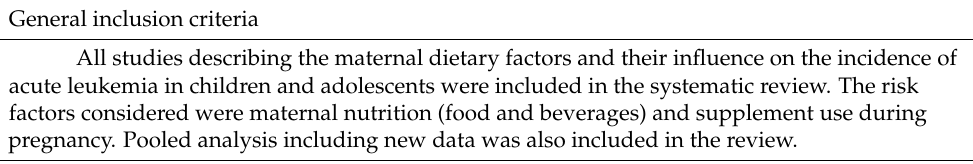
Table 1. Inclusion and exclusion criteria.